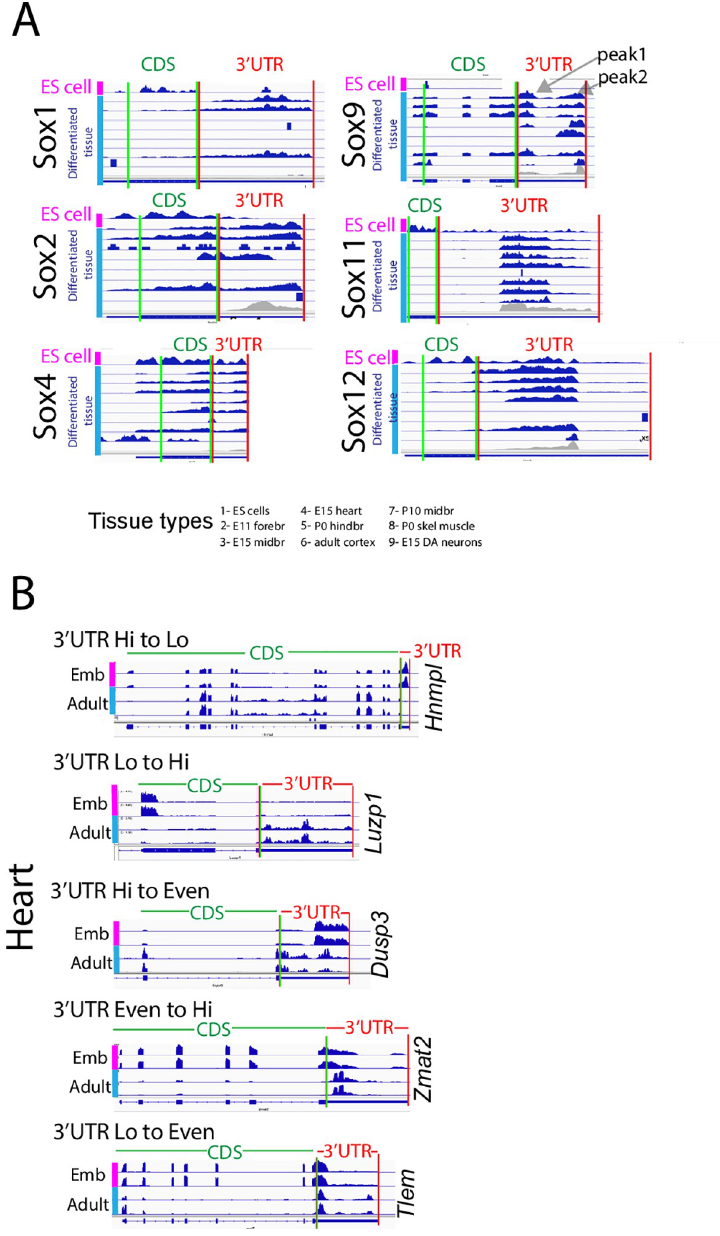
Fig 5. Widespread differential 3’UTR/CDS use is reflected in RNAseq data. (A) RNAseq data from 9 tissues showing 3’UTR and CDS expression for select Sox genes. For each gene, red vertical lines denote 3’UTR region, green denote CDS. Top trace for each gene (pink sidebar) is embryonic stem cell (ES) cell. Next eight traces (blue sidebar) show differentiated tissues, the first seven from open source Geo; noted at bottom, and the last, in-house RNAseq from E15 dopamine neurons [2]. As noted in [1, 2] and shown in gray, RNAseq traces are not uniform across the entire 3’UTR and can be divided into “peaks” and “valleys” (e.g., see Sox9 ; peak1 and peak 2; valley in between) (see text for definition). Each Sox gene shows greater (or in one case equal) 3’UTR to CDS expression in differentiated tissues. ES cells show the opposite, with high CDS/3’UTR. (B) Representative genes from embryonic (Emb; pink bars) and adult (Adult; blue bars) heart databases (each with two replicates) illustrate 3’UTR/CDS ratio changes over time; e.g., Hnmpl 3’UTR/CDS changes from high to low, Luzp1 from low to high. CDS—3’UTR junction marked by double red-green line and labels